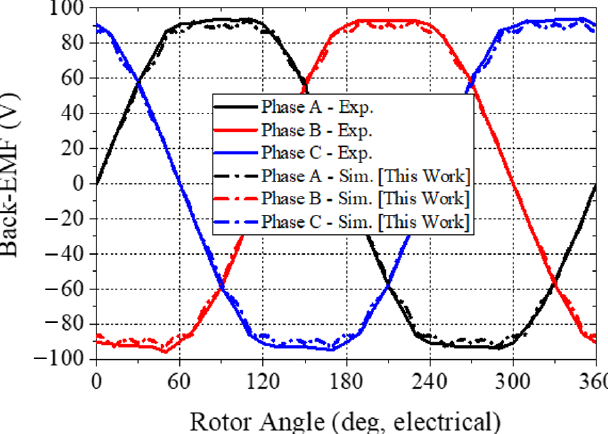
Figure 7. Comparison of measured [4] and simulated back EMFs of Phase A, B, and C windings at the base speed of 2800 rpm. the base speed of 2800 rpm.